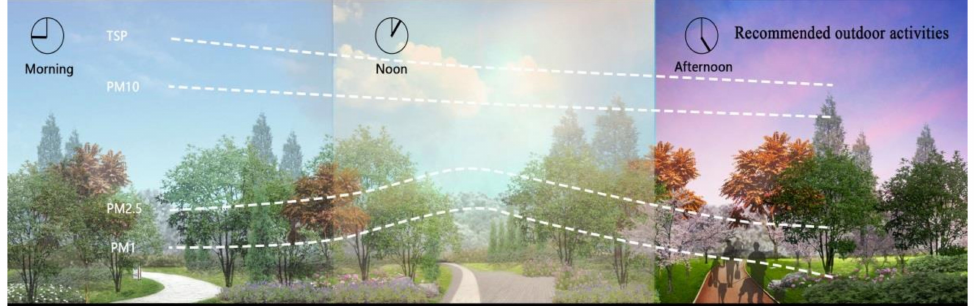
Figure 9. Schematic diagrams of time variation of different particle size